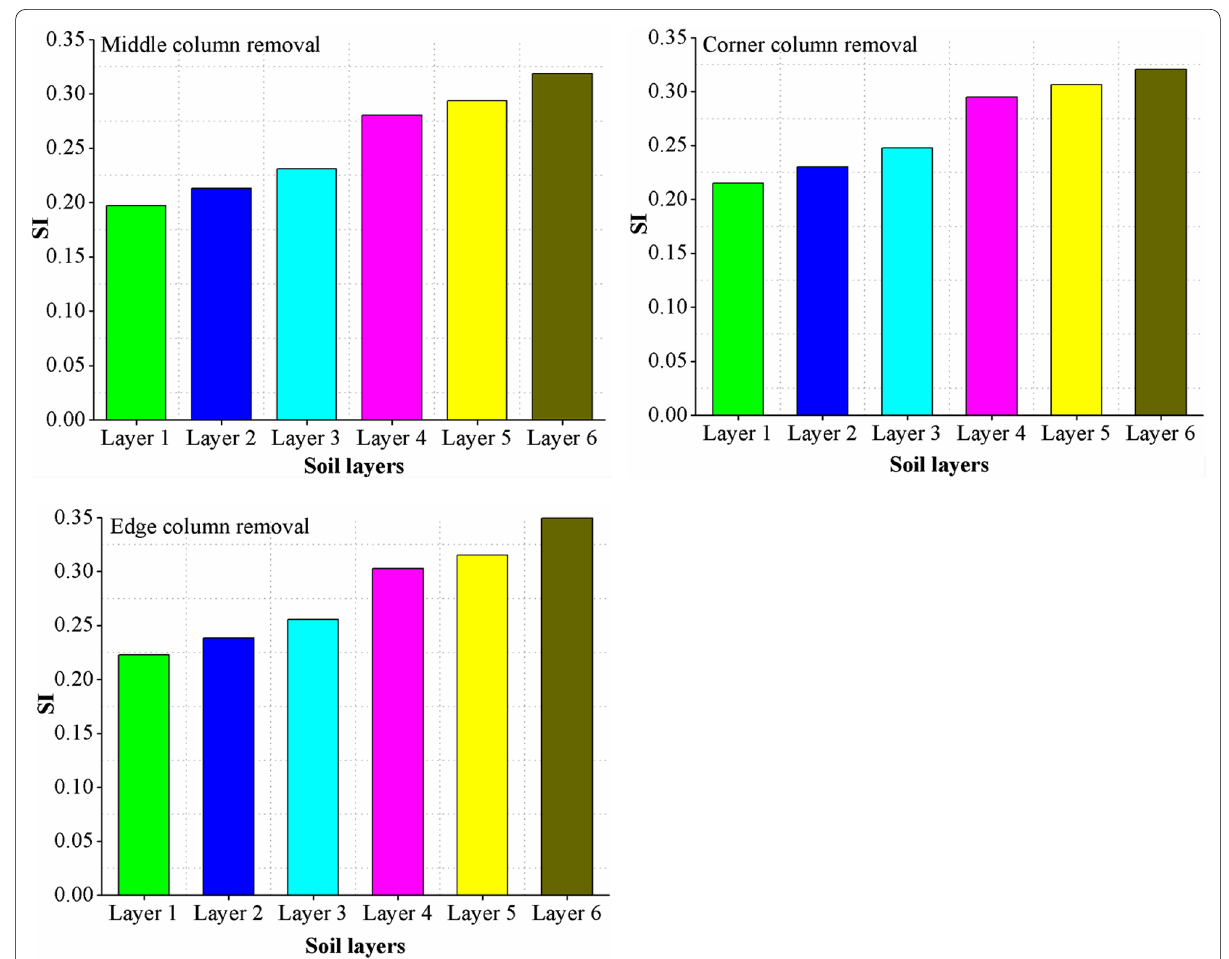
Fig. 17 The plot of sensitivity index versus soil